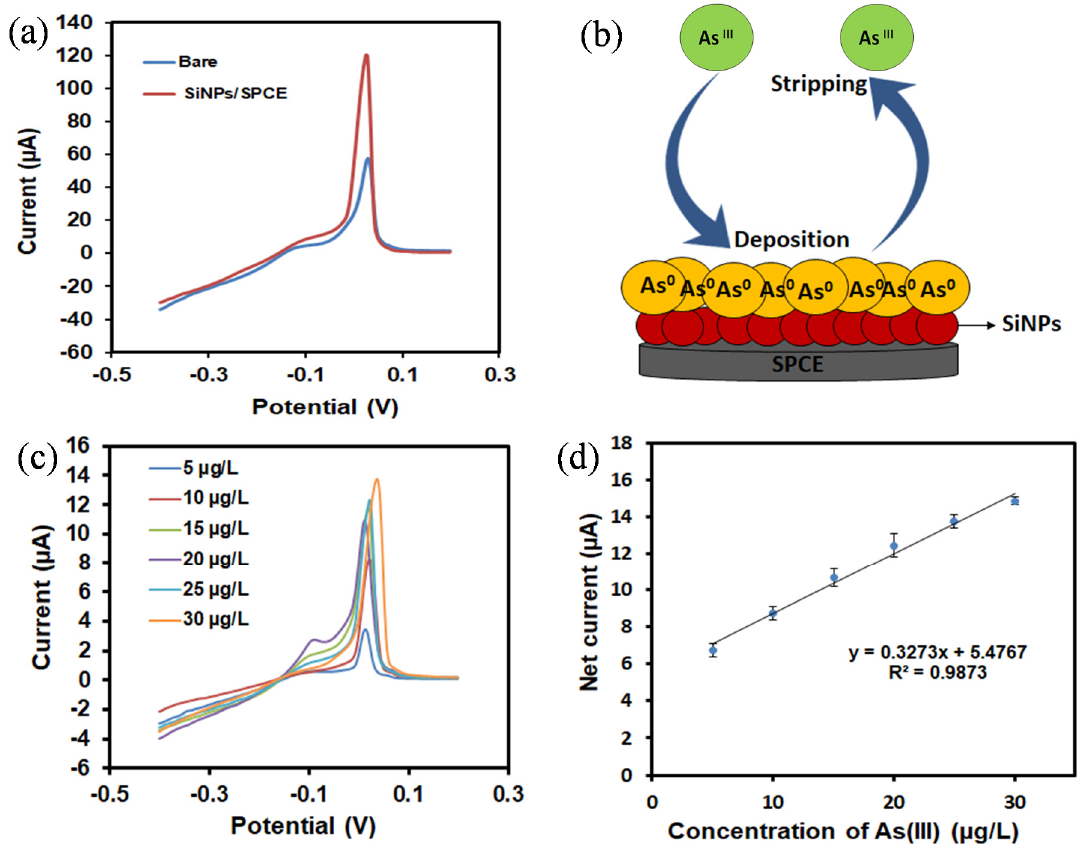
Figure 7. ( a ) Linear sweep anodic stripping voltammetry (LSASV) responses of the bare SPCE and SiNPs / SPCE in the presence of 1 mg / L As(III) in 1 M HCl solution (pH 1). ( b ) LSASV sensing mechanism of the SiNPs / SPCE towards As(III) detection. ( c ) LSASV responses of the SiNPs / SPCE towards As(III) in a concentration range of 5 to 30 µ g / L and ( d ) the corresponding linear calibration plots of the net current against As(III) concentrations.